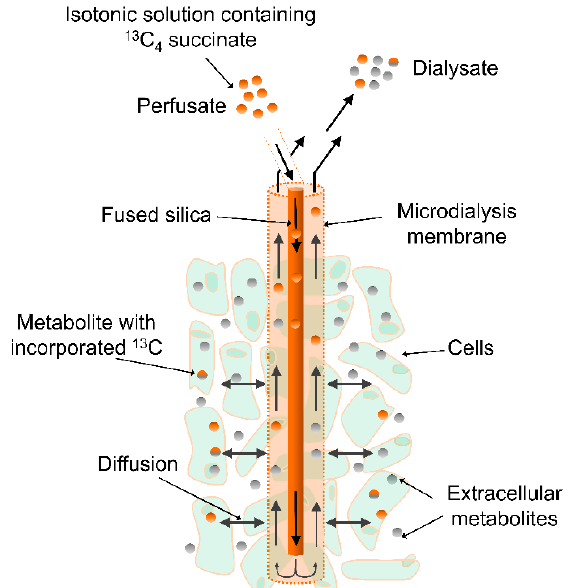
Figure 1. Microdialysis set-up. Ringer’s solution with labeled 13 C-succinate is delivered to the microdialysis probe in the rat brain. Diffusion through the membrane allows 13 C-succinate to be taken up and metabolized by the surrounding cells.